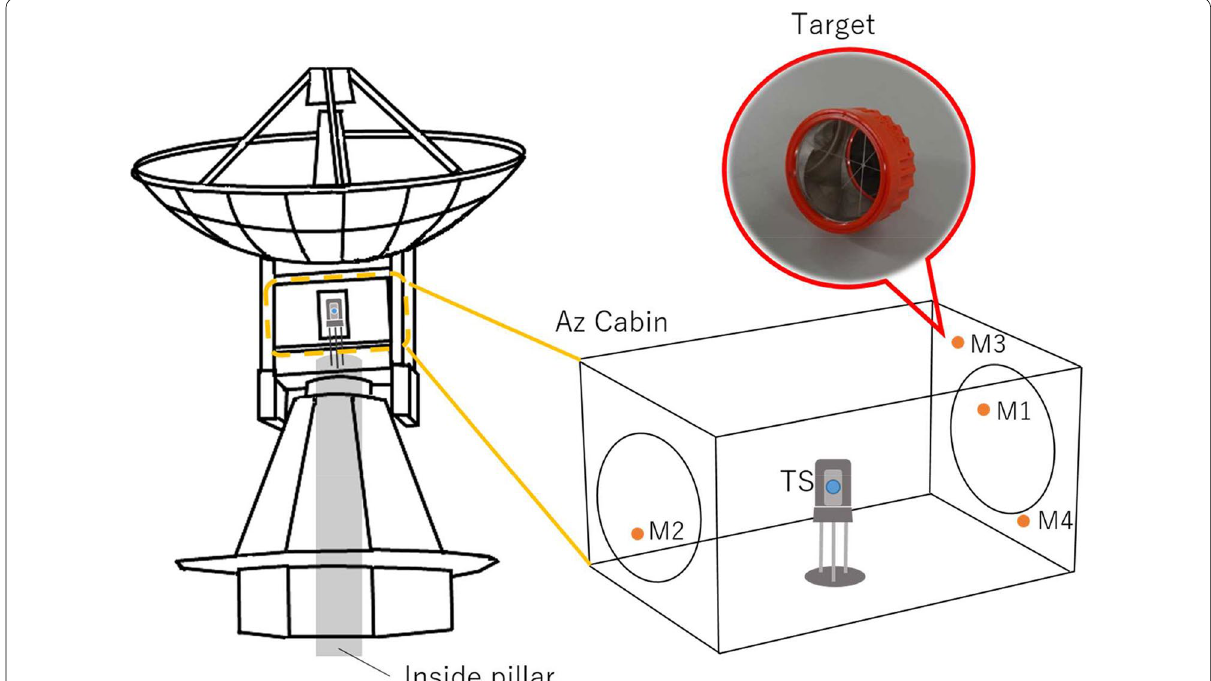
Fig. 5 Schematic view of antenna structure and target positions for inside method. M1, M2, M3, and M4 represent positions, where the target mirror is attached to the inside wall of the Az